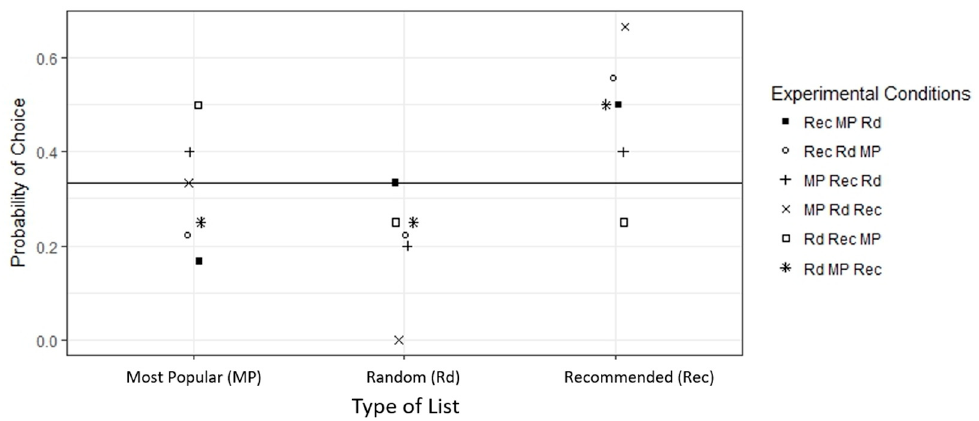
Figure 2. Probability of choosing each type of list on the screen display across the 6 experimental conditions.